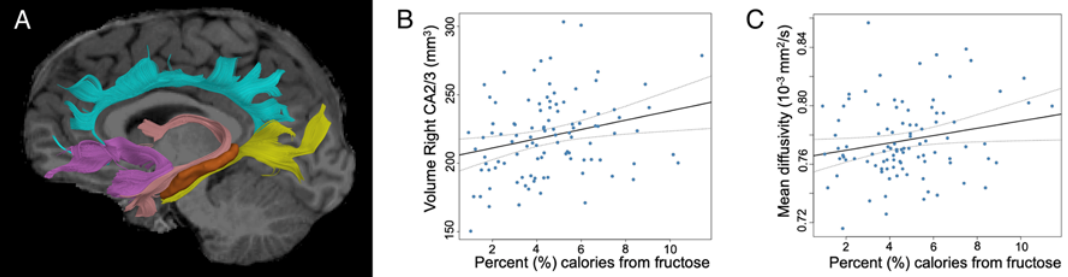
Figure 1. Associations with fructose consumption. ( A ) Using regions of interest for the hippocampus (orange) and its major connections (fornix: pink, uncinate: purple, and the cingulum, which was segmented into the temporal part: yellow and the prefrontal part: turquoise ) , we identified associations between fructose consumption and the volume of the right CA2/3 subfield of the hippocampus ( B ) and the mean diffusivity of the right cingulum, prefrontal connections ( C ). (B,C ) Graphs show the unadjusted model with no covariates. Solid line indicates the best fit linear trend, with dotted lines showing the confidence interval. Notably, these graphs show the results from Model 1 (Tables 1 and 2, respectively).